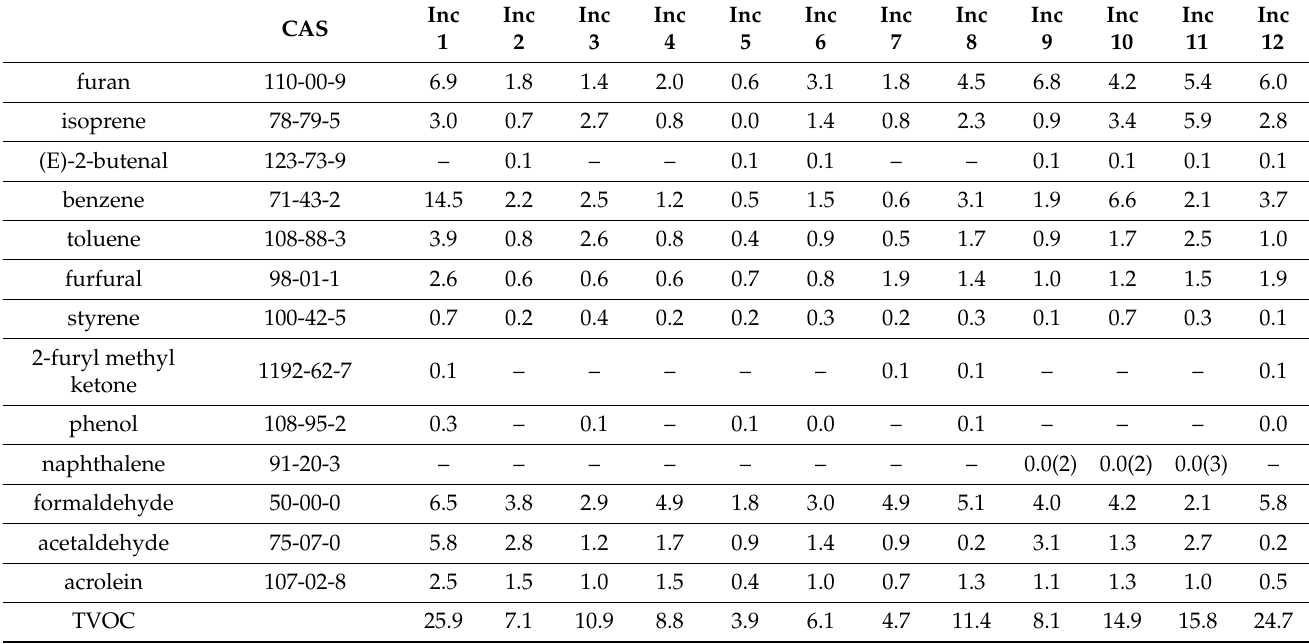
Table 6. Average TWA values (worst-case time-weighted average) ( µ g/m 3 ) for TVOC, VOCs, and VVOCs selected in this study in the test chamber for the twelve products